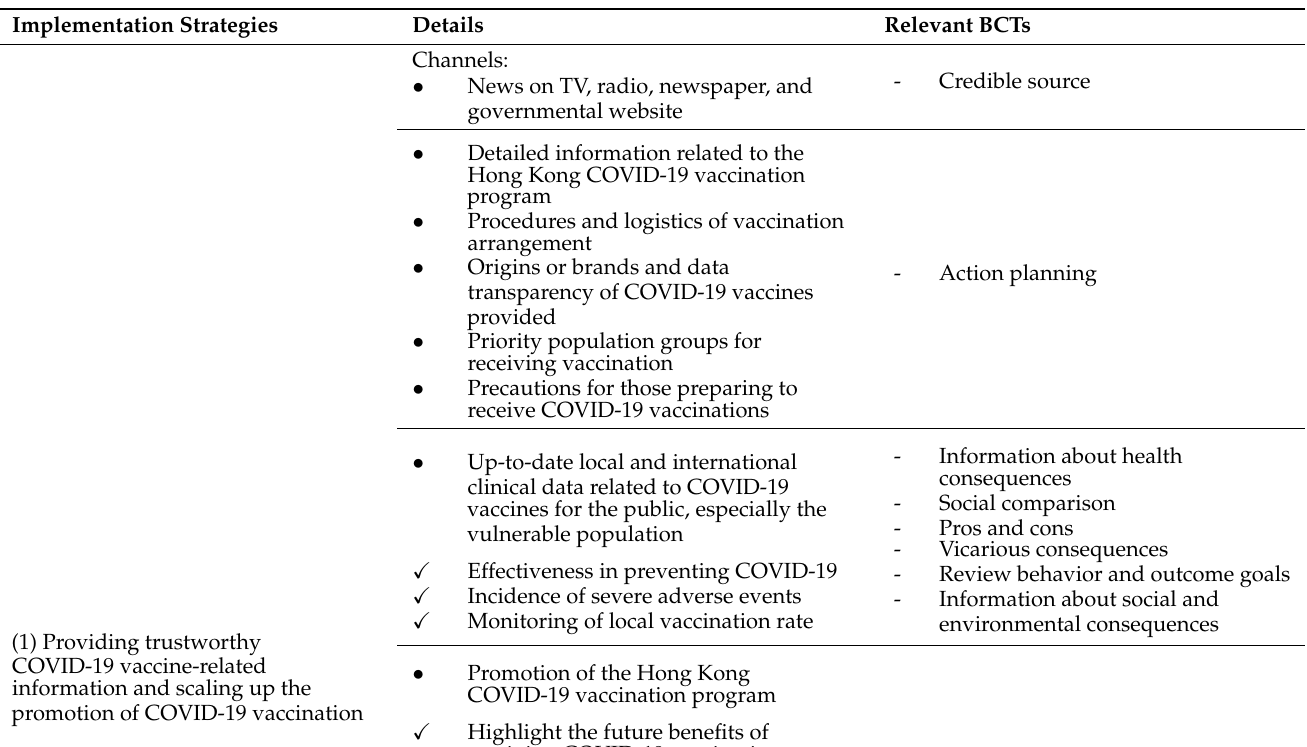
Table 3. Implementation strategies to maximize the public’s willingness to receive the COVID-19